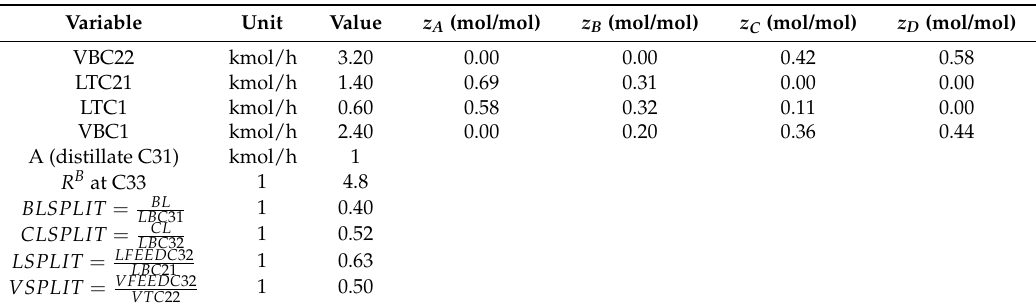
Table 3. Initial values used for rigorous simulation in Aspen Plus ®